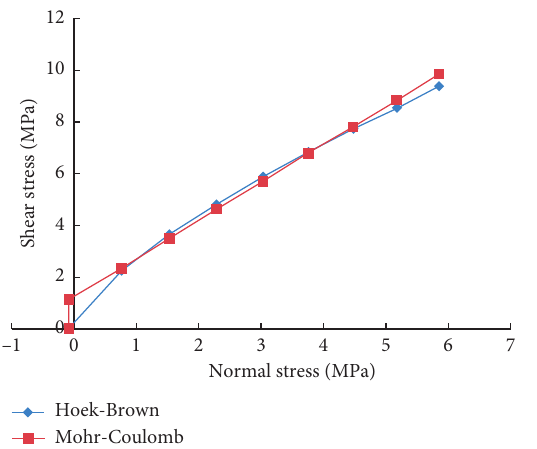
Figure 16: Minor-major principal stress